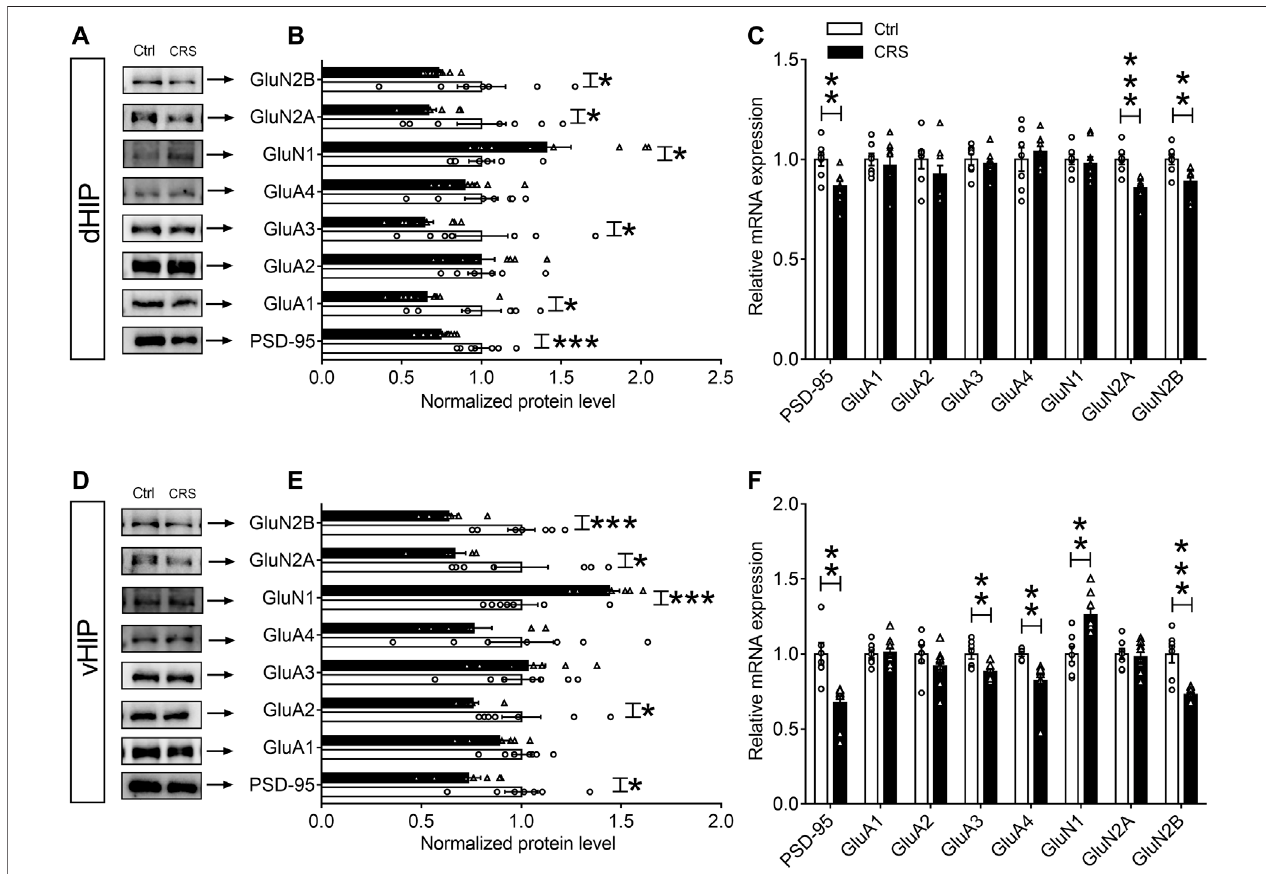
FIGURE2| Expressionofglutamatereceptorsinthehippocampusofchronicallystressedmice. (A,B) CRSselectivelydecreasedtheexpressionlevelsofPSD-95, GluA1, GluA3, GluN2Aand GluN2B, while increased GluN1expression inthe dHIP. (C) ThemRNA levels of PSD-95, GluN1and GluN2Awere reduced in thedHIP after CRS. (D,E) CRS selectively decreased the expression of PSD-95, GluA2, GluN2A and GluN2B, while increased GluN1 expression in the vHIP. (F) The mRNA levels of PSD-95,GluA3,GluA4,andGluN2Bwerereduced;whileGluN1mRNAlevelwasupregulatedinthevHIPafterCRS.Dataarepresentedasmean ± SEM.One-way ANOVA for all. n (cid:1) 7 – 9 per group for (B,C,E,F) . * p < 0.05, ** p < 0.01, *** p < 0.001 vs. Ctrl group.